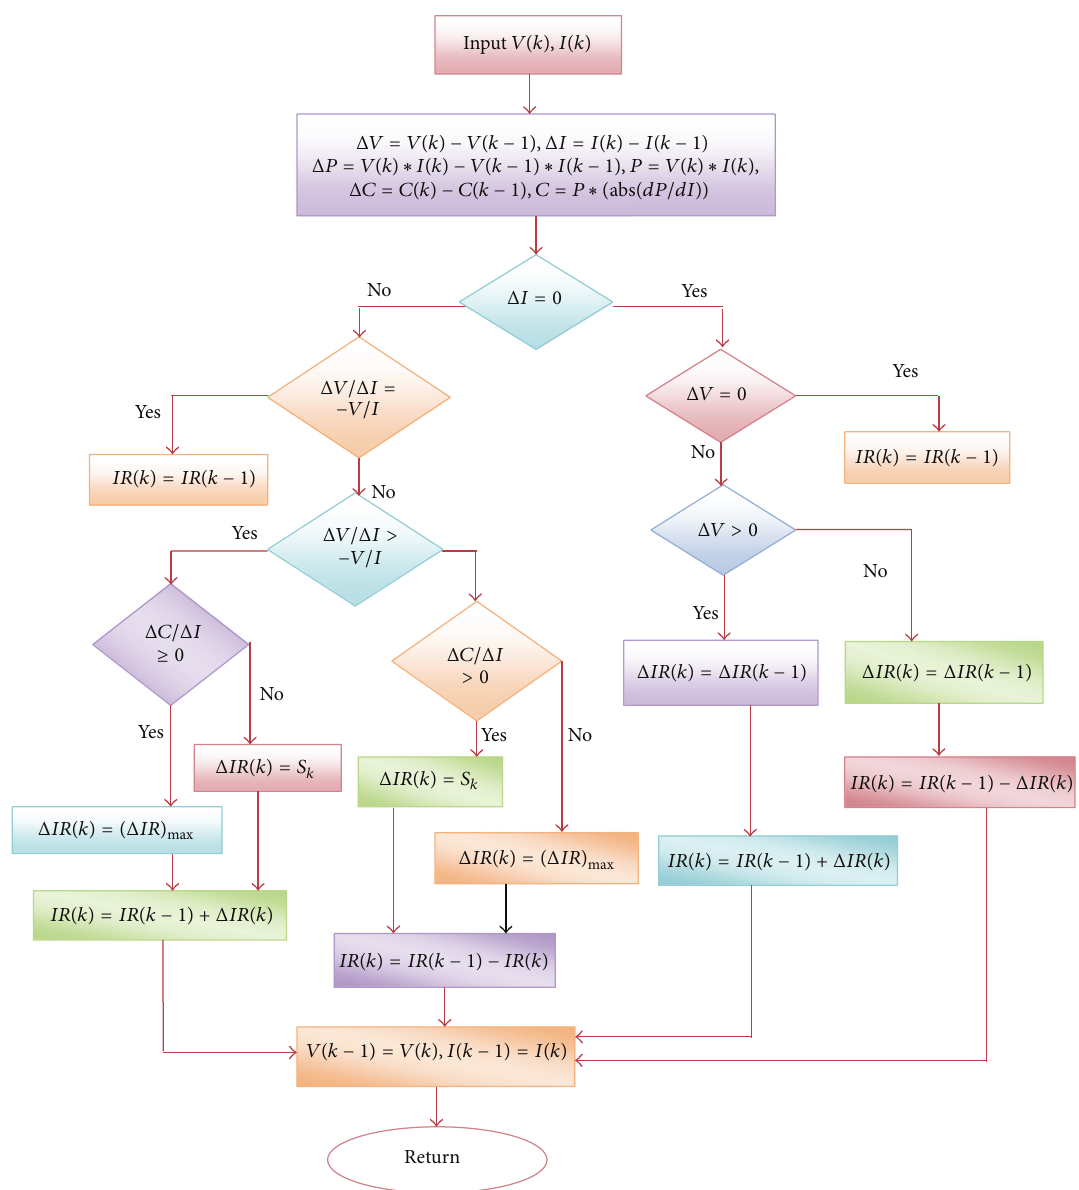
Figure 7: Flowchart of VSS-INR MPPT